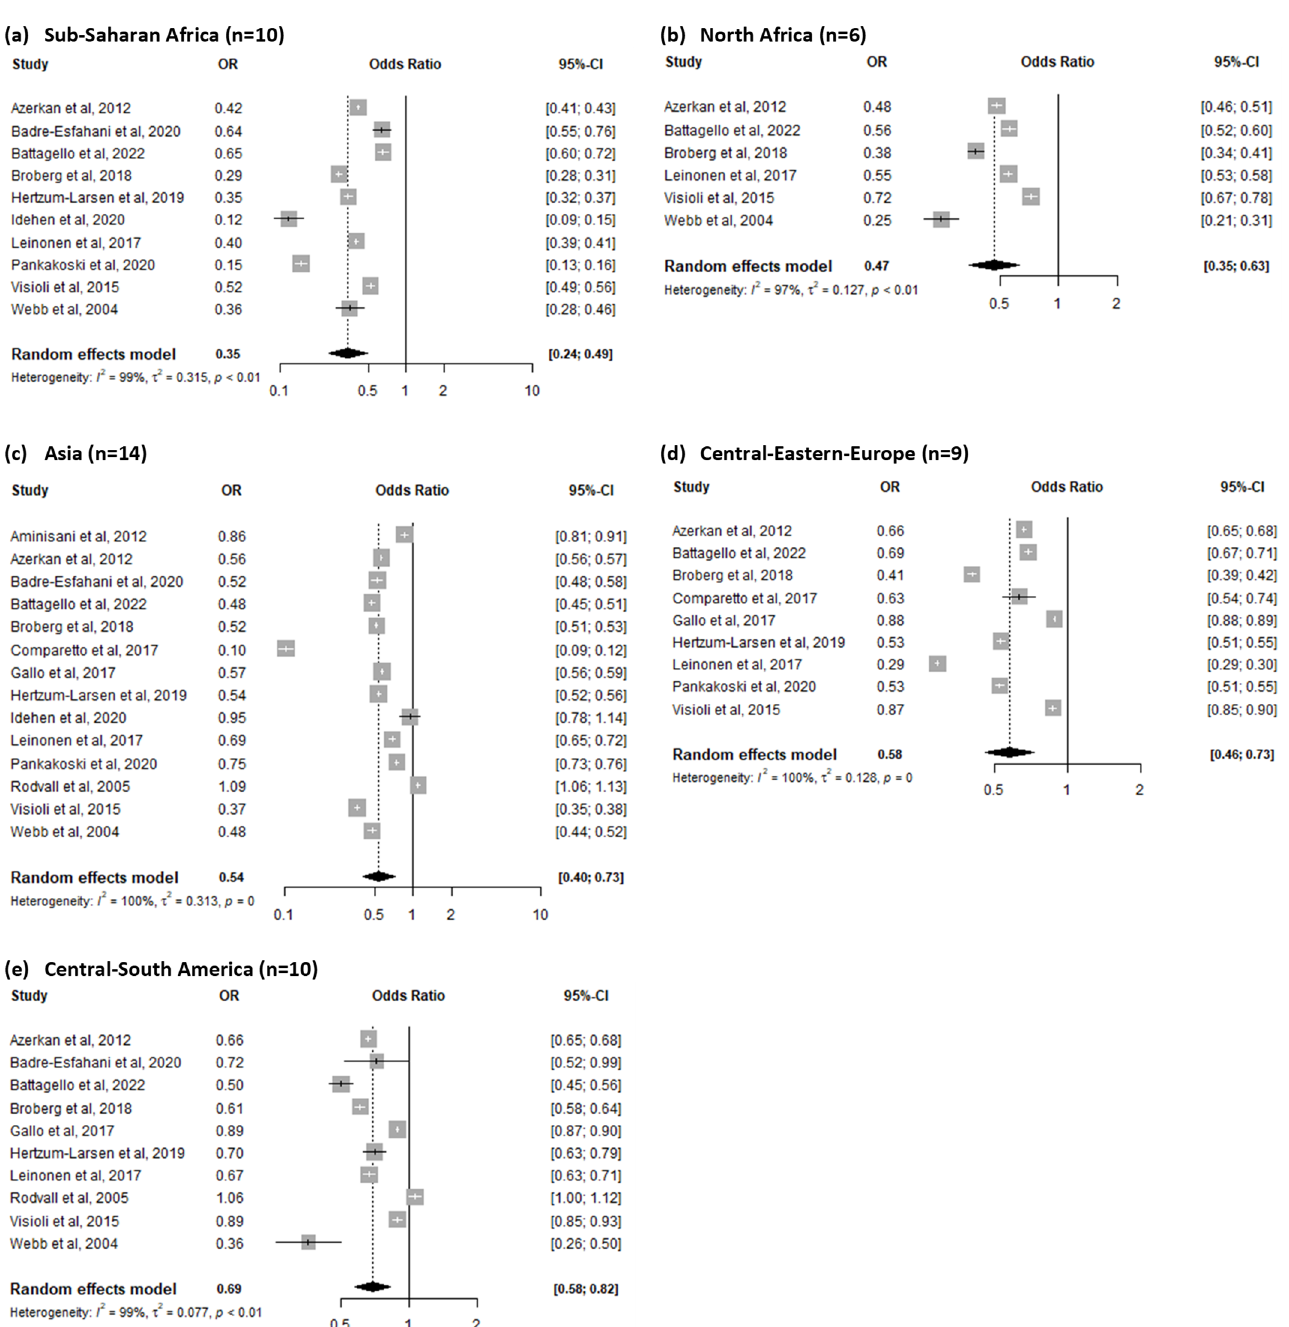
Figure 3. Forest plot for screening participation among Sub-Saharan African ( a ), North African ( b ), Asian ( c ), Central-Eastern European ( d ) and Central-South American ( e ) migrants compared to native populations [16,33–38,40–44,46,47].